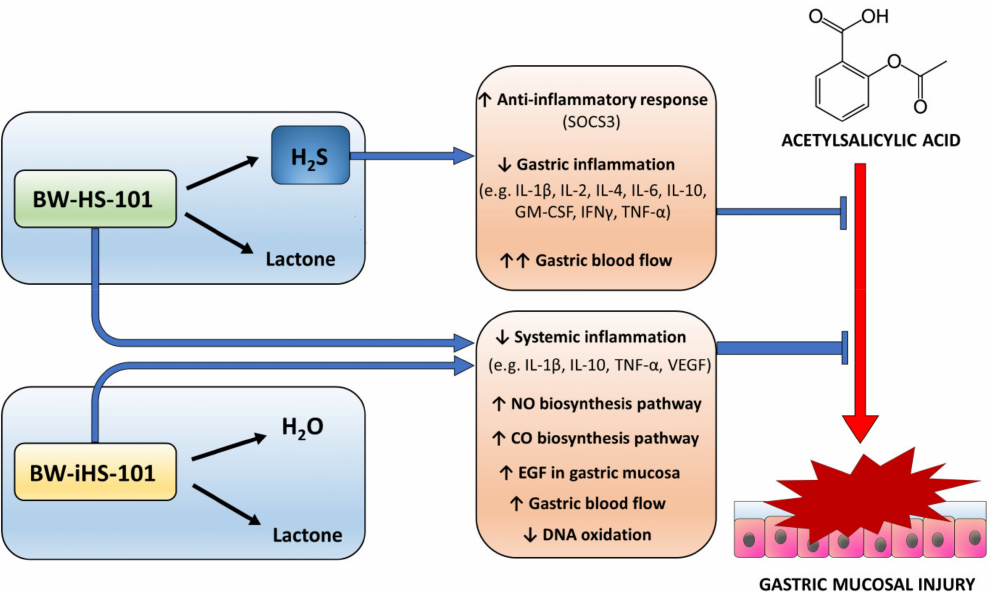
Figure 8. Overview on the possible mechanisms of BW-HS-101 and BW-iHS-101 gastroprotection against acetylsalicylic acid-induced injury. Abbreviations: H 2 S—hydrogen sulfide, NO—nitric oxide, CO—carbon monoxide, SOCS3—suppressor of cytokine signaling 3, IL—interleukin, TNF—tumor necrosis factor, VEGF—vascular endothelial growth factor A, EGF— epidermal growth factor, GM-CSF—granulocyte-macrophage colony-stimulating